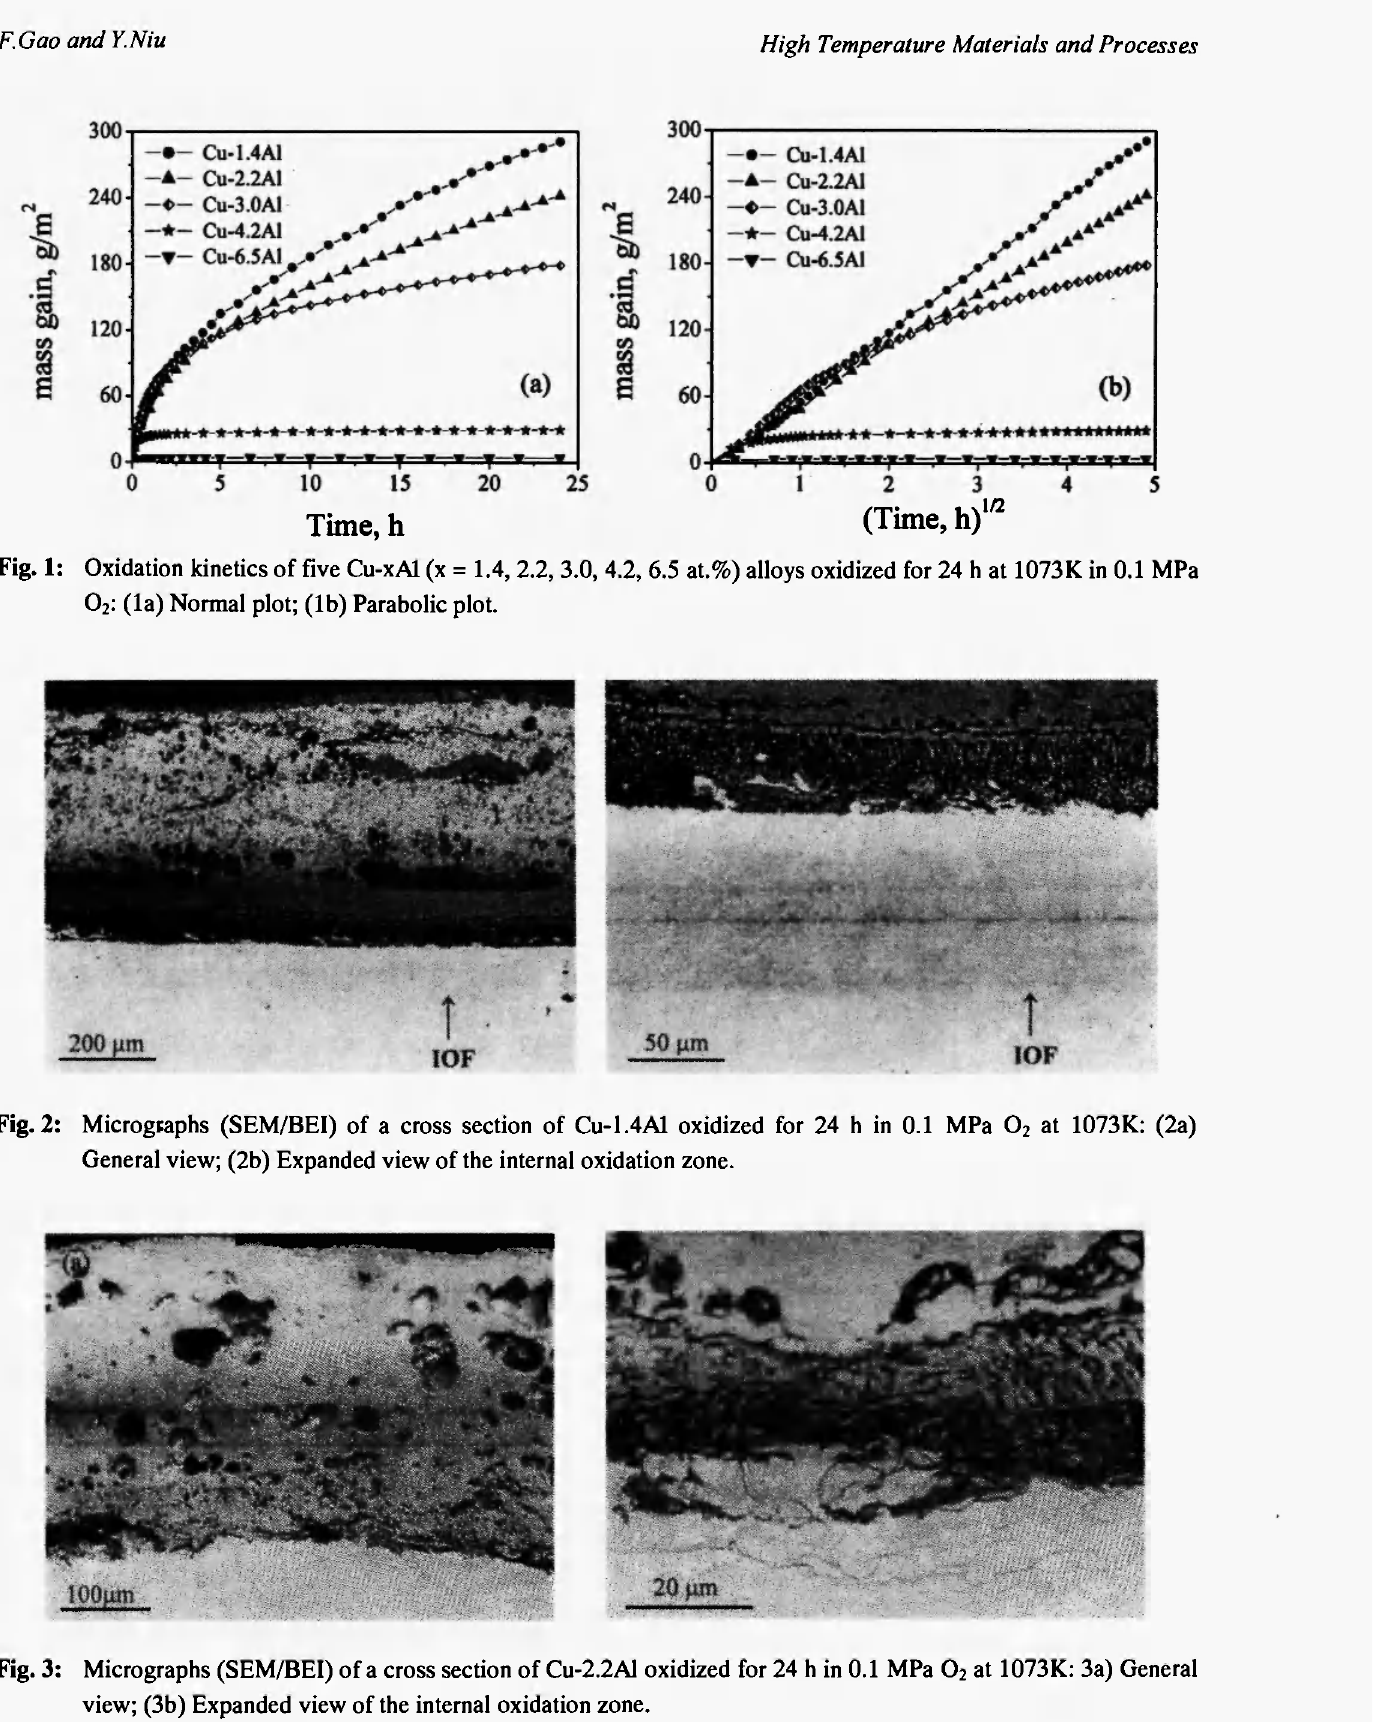
Fig. 3: Micrographs (SEM/BEI) of a cross section of Cu-2.2A1 oxidized for 24 h in 0.1 MPa 0 2 at 1073K: 3a) General view; (3b) Expanded view of the internal oxidation